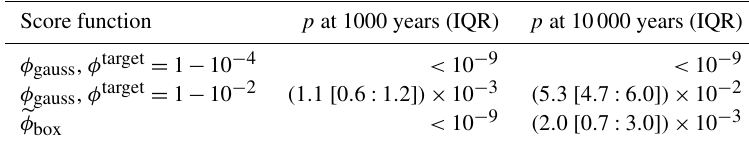
Table 1. Results of the transition probabilities for the AMOC model using different score functions. Score